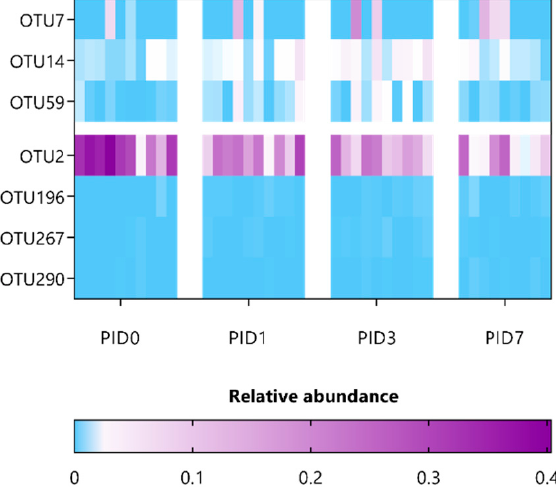
Figure 10. Heatmap representing the relative abundance of significant gut microbial dysbiosis markers detected in L. indica PCC 8005-given mice following sham-irradiation as listed in Table 2, n = 10 per time point. OTU = operational taxonomic unit; PID = post-irradiation day. Table 3. Differential operational taxonomic units (OTUs) detected in L. rhamnosus GG-given mice following pelvic irradiation. PID = post-irradiation day.